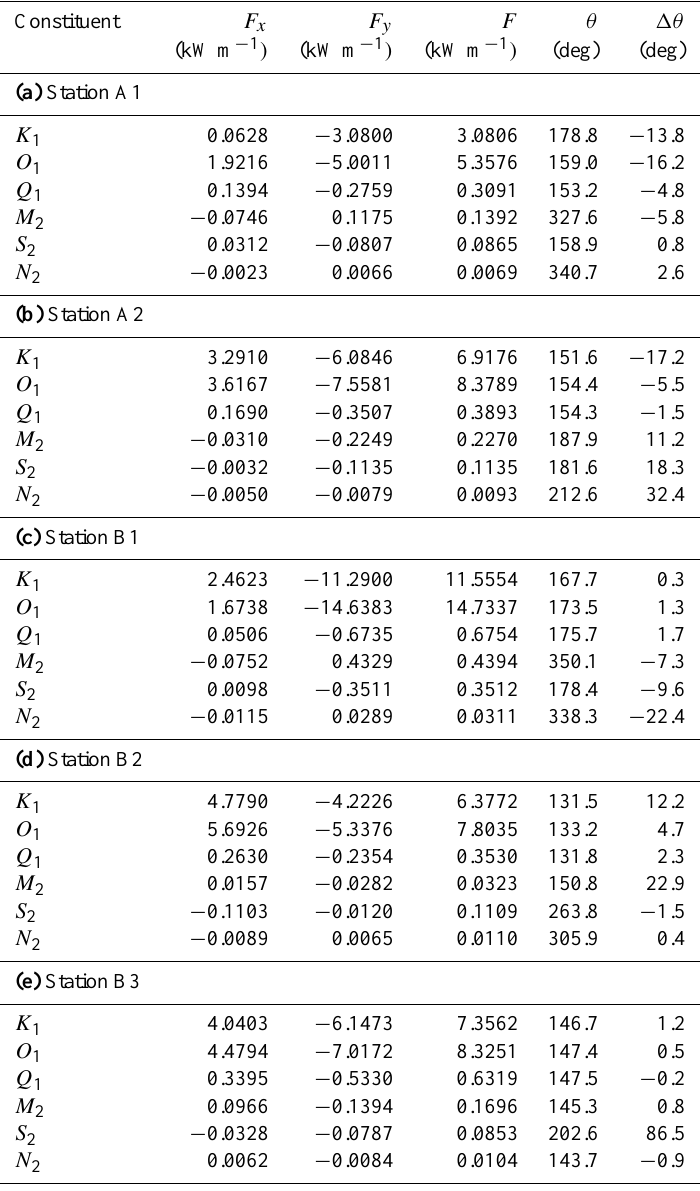
Table 5. Tidal energy flux